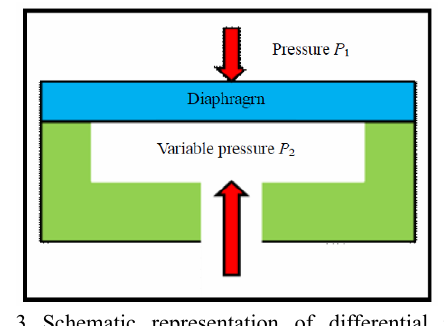
Fig. 3 Schematic representation of differential pressure sensor.